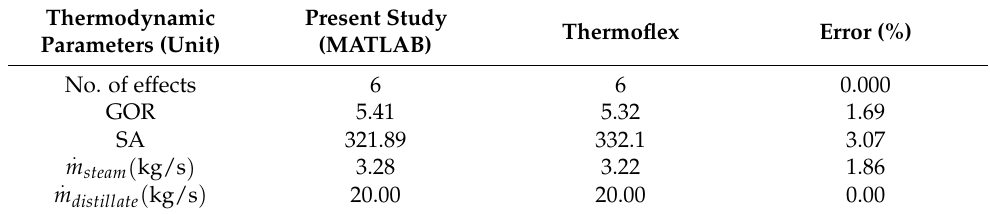
Table 8. Validation of the multi-effect desalination (MED) results obtained by the proposed approach.